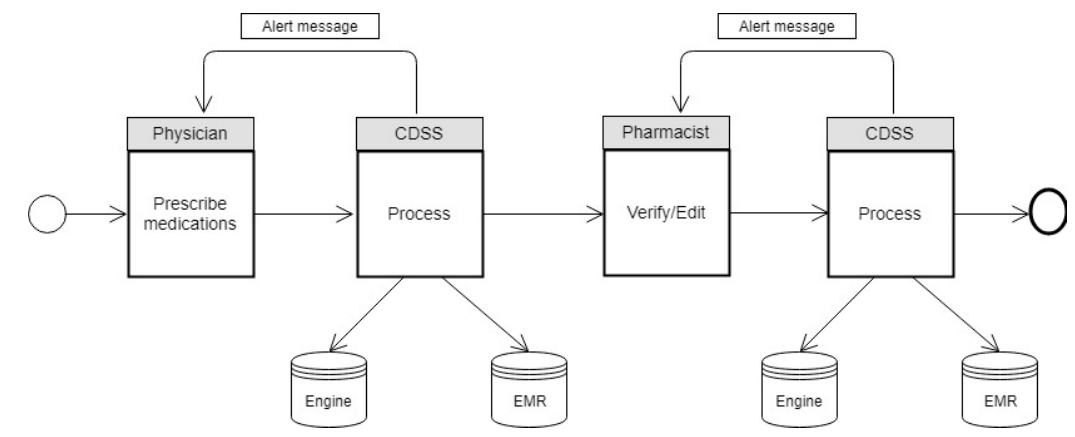
Figure 1. CDSS workflow in BESTCare 2.0 .